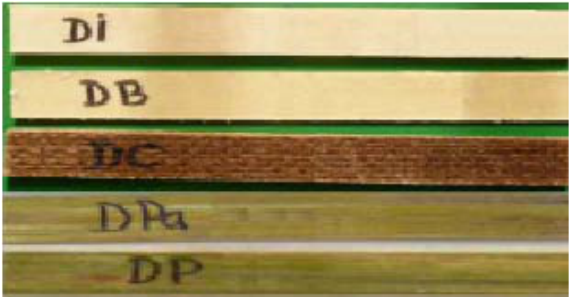
Figure 2. Samples obtained of hybrid resin with 65% dammar proportion, reinforced with fabrics of flax (marked with DI), cotton (marked with DB), hemp (marked with DC), wheat straw (marked with DPa), and cattail leaves (marked with DP).